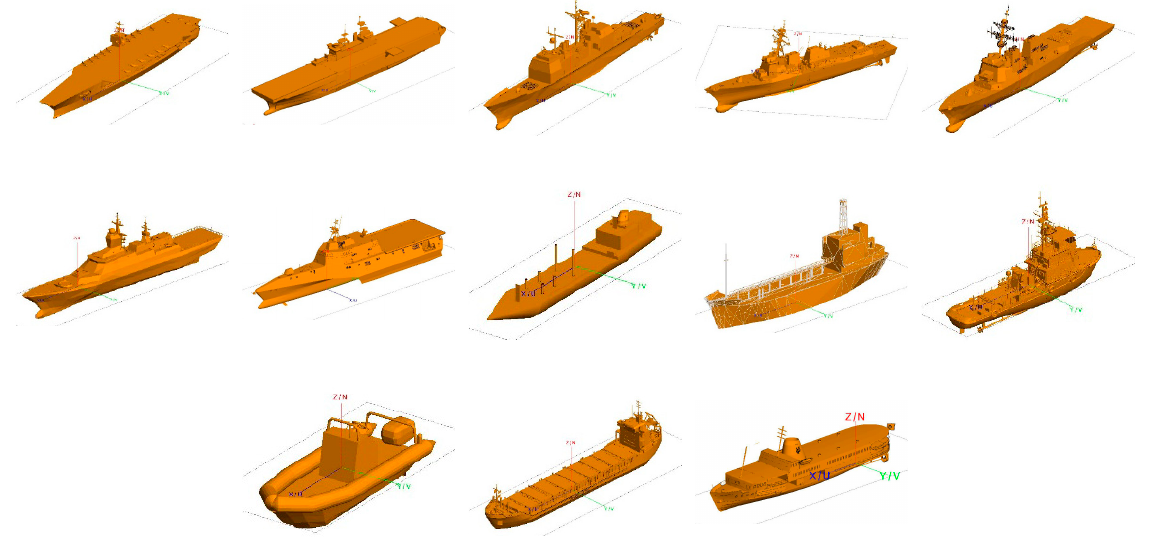
Figure 6. Models of all the ship targets.